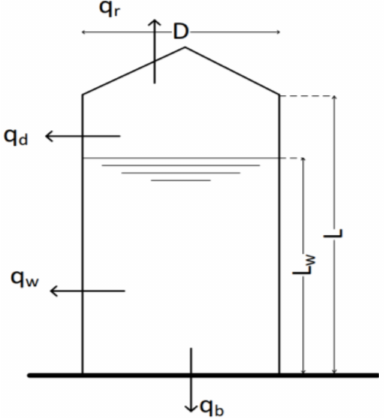
Figure 3. Typical vertical–cylindrical